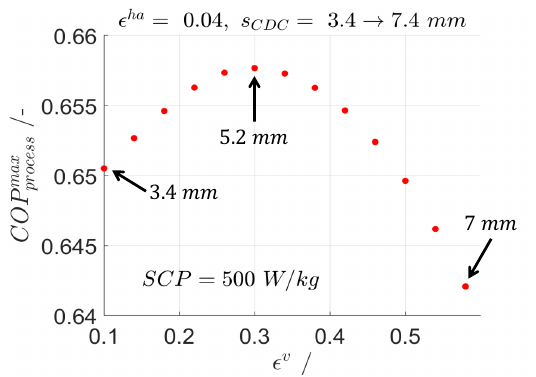
Figure 12. Varying, maximal COP max for different macro-pore volume fractions and layer heights.